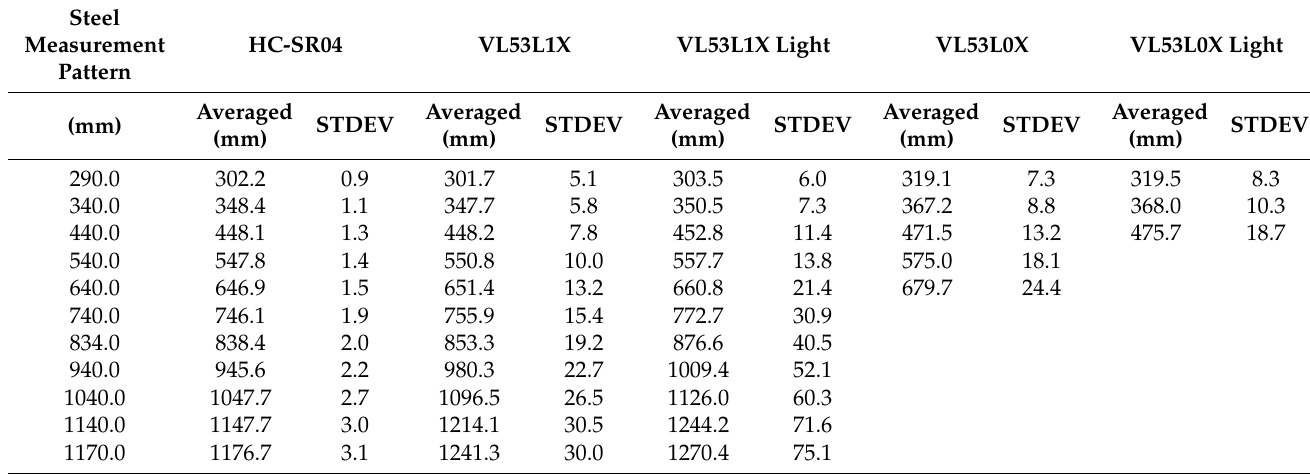
Table 3. The normalized values of similar